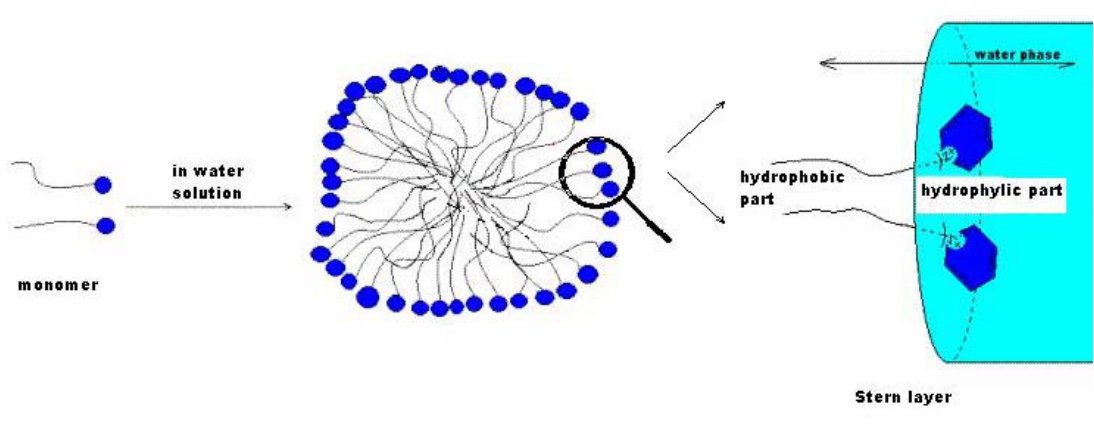
Figure 1. Forming of the